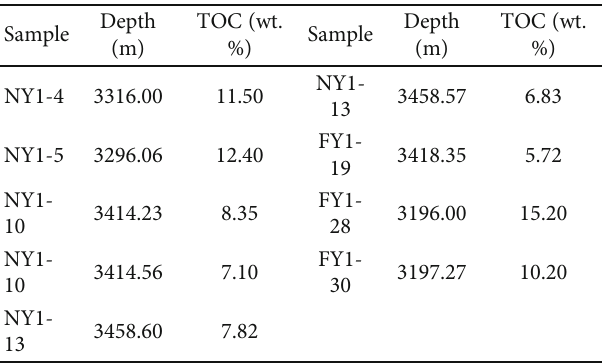
Table 3: The data of microanalysis of total organic carbon (TOC) of the host rock.